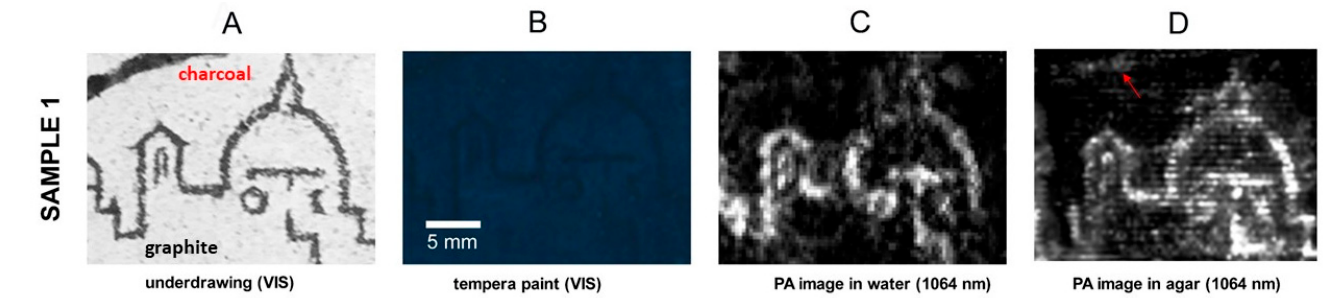
Figure 2. Reflectance PA imaging results on graphite and charcoal underdrawings ( A ) hidden under Egyptian blue tempera paint ( B ); comparison of results in water ( C ) and agar ( D ). The red arrow indicates the area corresponding to the charcoal outline in a PA image. The scale in 2B is valid for all images in the row.